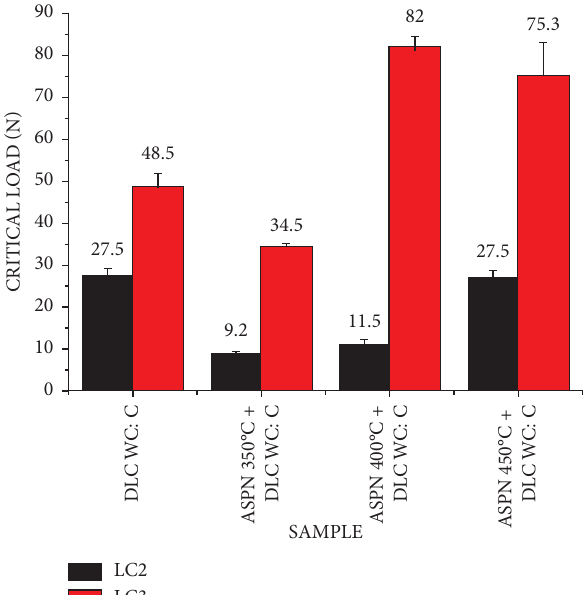
Figure 7: Experimental data derived from the scratch test with the corresponding values of critical load (LC2 and LC3) for DLC WC:C coating sample.